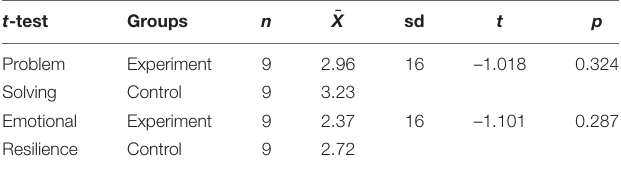
TABLE 3 | Independent sample t -test findings on the examination of the difference in the problem-solving and emotional resilience pretest scores according to the experimental and control groups.